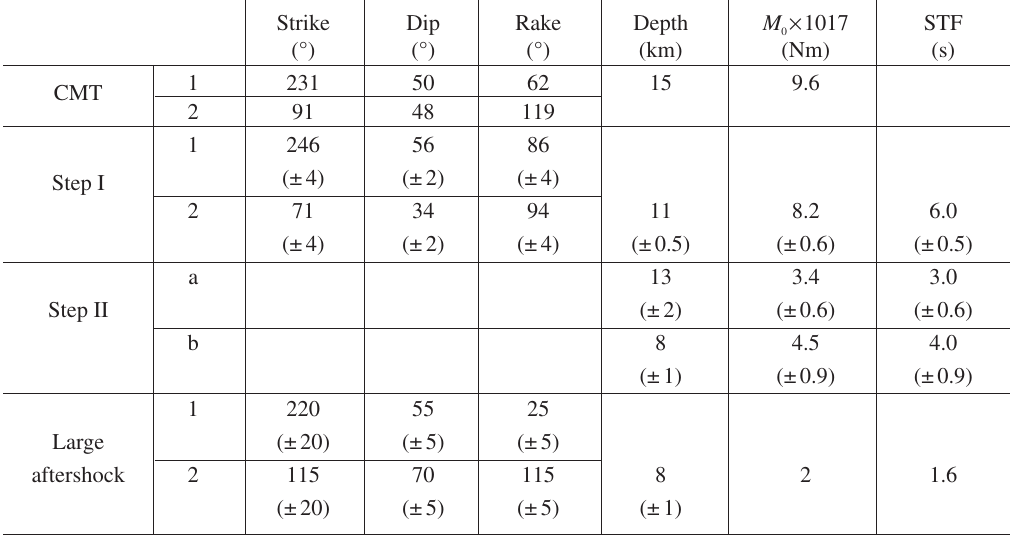
Table II. Source parameters of the main shock and the large aftershock for fi nal solutions obtained respectively from inversions I and II and the BRB modeling. (1) and (2) indicate the nodal planes; (a) and (b) correspond